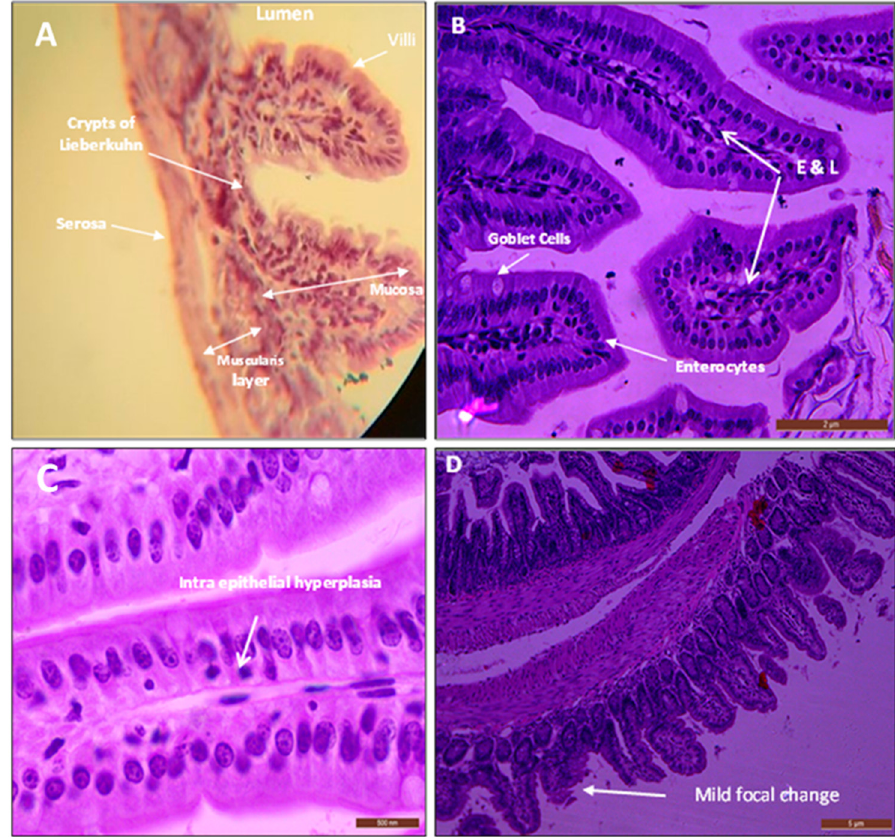
Figure 13. ( A ) Normal intestinal mucosa shows the mucosa lined with columnar epithelium, the submucosa, muscularis properia, and finally serosa. With simple columnar absorptive cells (enterocytes) and goblet cells in ( B ) intestines of mice treated with 300 mg/kg revealed mild focal edema (E) and a few scattered chronic inflammatory cells lymphocytes (L). ( C ) Sections of the intestine show intraepithelial or intra-glandular lymphocytes (chronic inflammatory cells). ( D ) Focal mild broadening and atrophic changes as mild destruction occurred in the surface of villi (mild focal change). Stained with hematoxylin and eosin. Scale bars for ( A , D ) 5 μ m, 500 μ m for ( C ), and 2 μ m for ( B ).